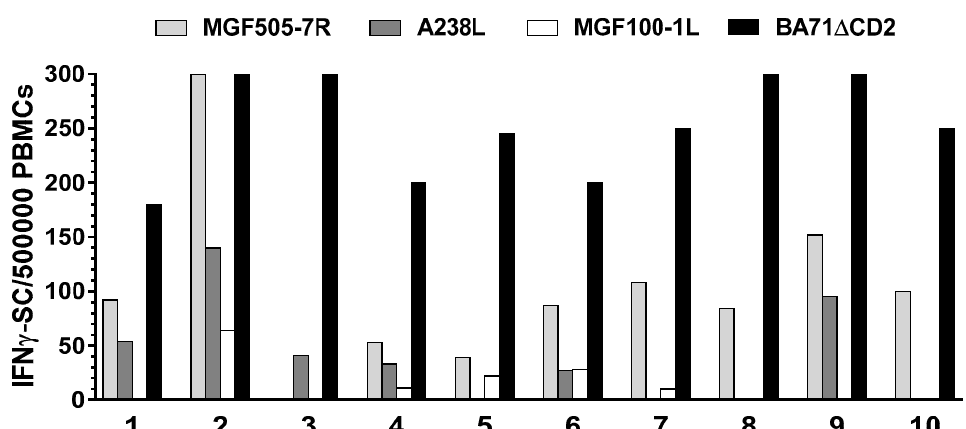
Figure 2. IFN γ response assessed by ELISpot assay using fibroblasts transfected with the pCMV-Ub-MGF505-7R, pCMV- Ub-A238L and pCMV-Ub-MGF100-1L plasmids as APCs, and PBMCs from ASF-convalescent animals as effector cells (pig individual numbers on the x axis). Values represented correspond to the specific IFN γ -SC (spots) found after stimulation with autologous fibroblasts transfected with each specific plasmids, once subtracted the number of spots found with pCMV-Ub (empty plasmid) transfected fibroblasts (always <10). Levels of specific IFN γ -SC observed after stimulation with the BA71 Δ CD2 virus are also shown.